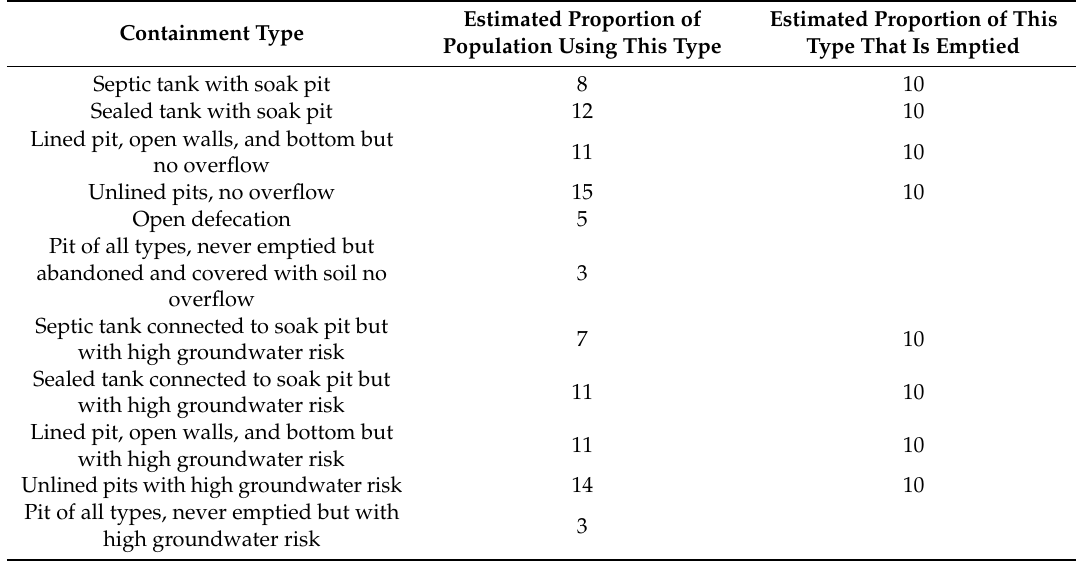
Table 4. Estimates of Sanitation Containment Matrix for fecal sludge flow